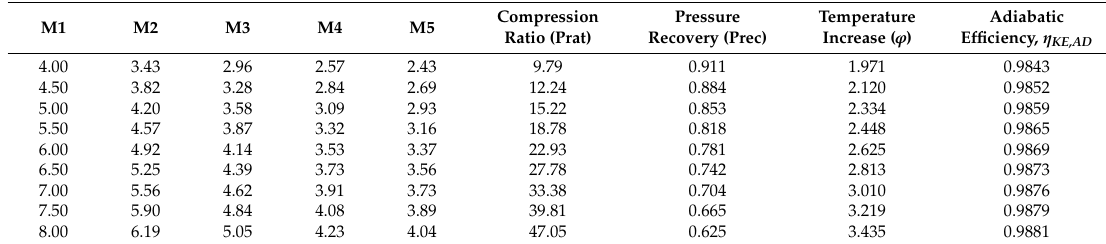
Table 5. Theoretical calculations for the refined four ramp inlet.